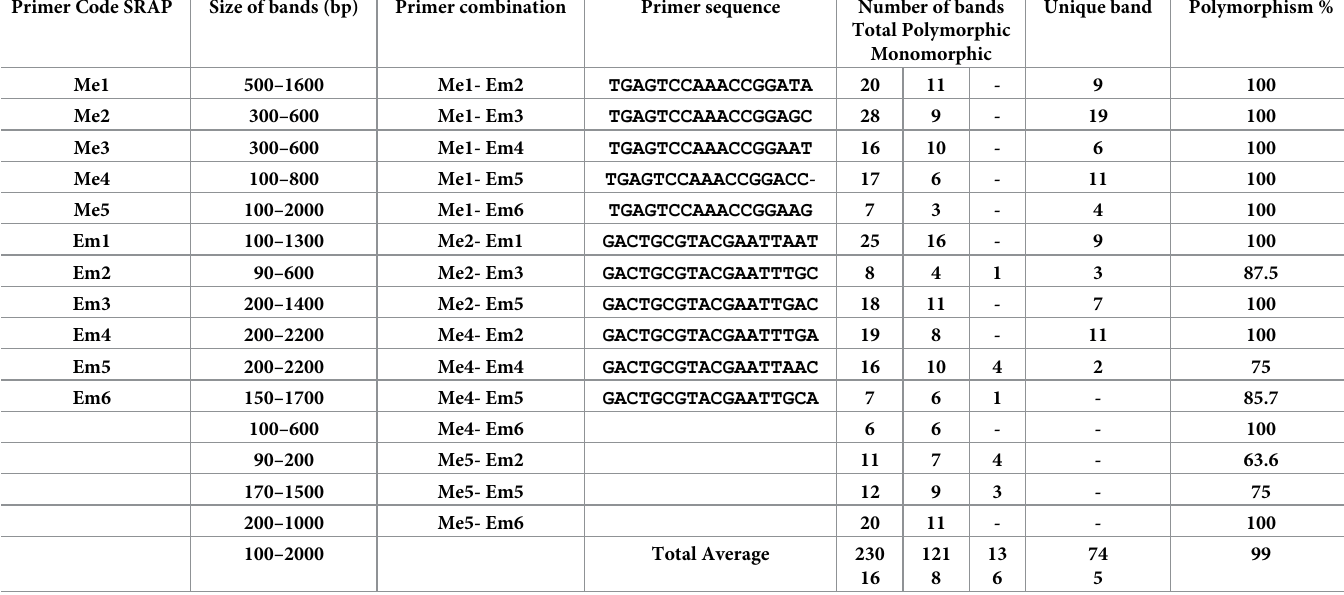
Table 8. Primer code, primer sequence, Size of bands and combination total bands, polymorphic bands, unique band and percentage of polymorphism in the SRAP primer. Primer Code